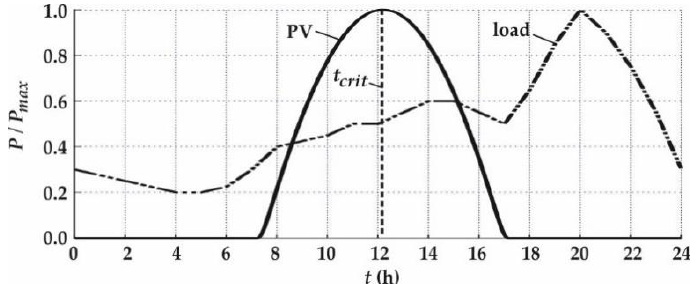
Figure 22. Load consumption and PV production profiles.